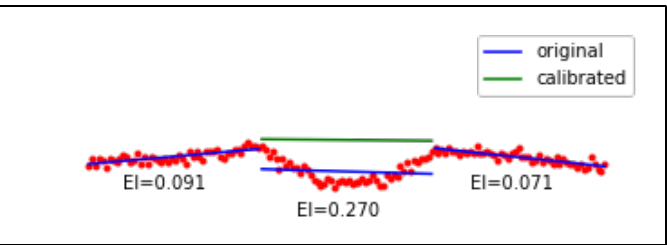
Figure 12. Schematic diagram of plane fitting and calibration.